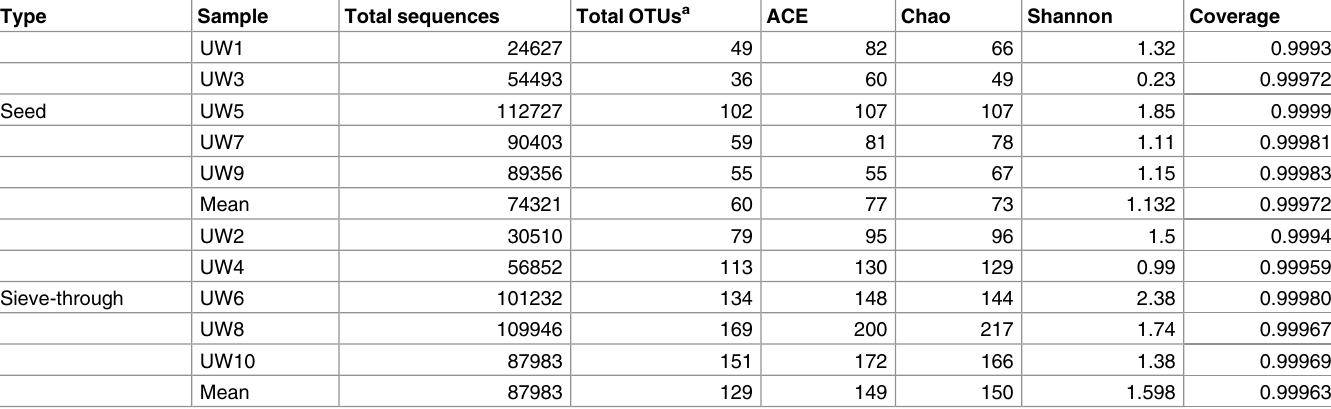
Table 1. MiSeq sequencing results and diversity estimates for each sample.